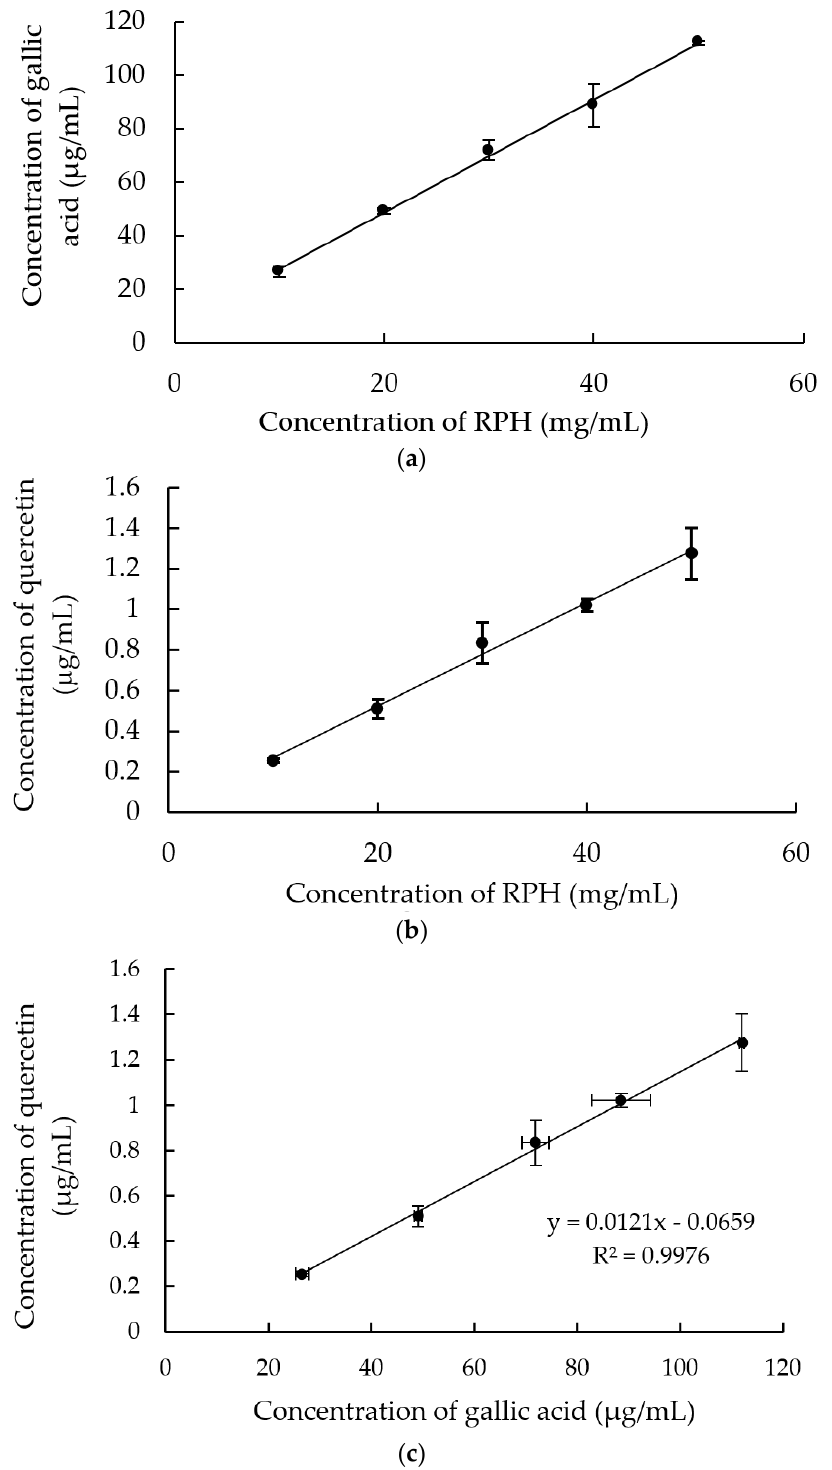
Figure 1. ( a ) Total phenolic concentration (TPC) and ( b ) total flavonoid concentration (TFC) versus rice protein hydrolysate (RPH) concentration. ( c ) relationship between the TPC and TFC of RPH.